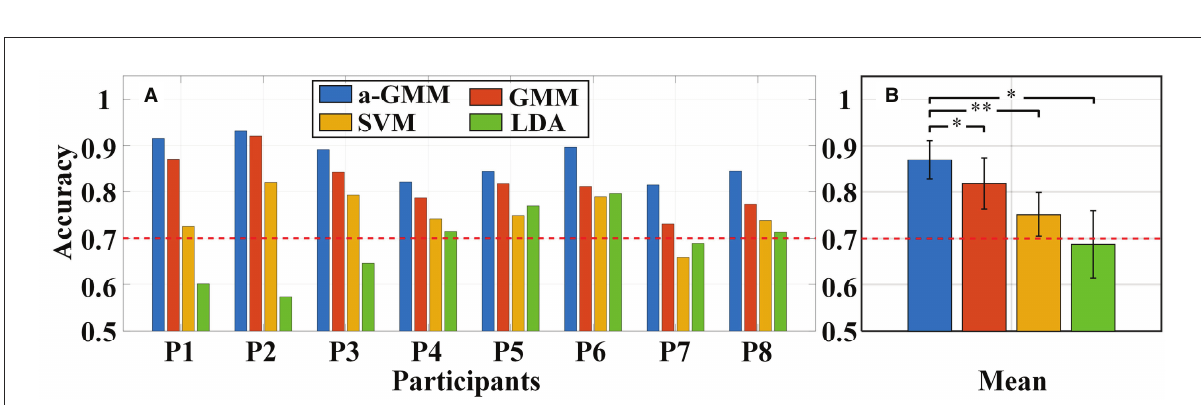
FIGURE12 Classification accuracy of MA vs. MS for different classifiers constructed by extracting the same level features: (A) Individual accuracy and (B) average accuracy. Error bars indicate the standard deviations, *Represents the significant difference, * p < 0.01 and ** p < 0.001. The red dashed line indicates 70% classification accuracy of effective binary BCI communication.